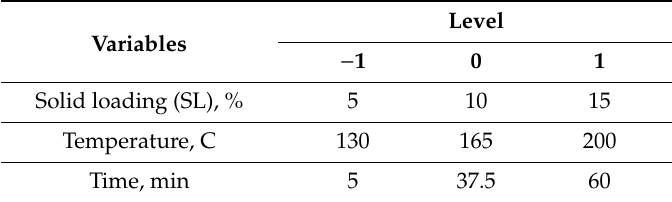
Table 1. Box–Behnken design experiment variable